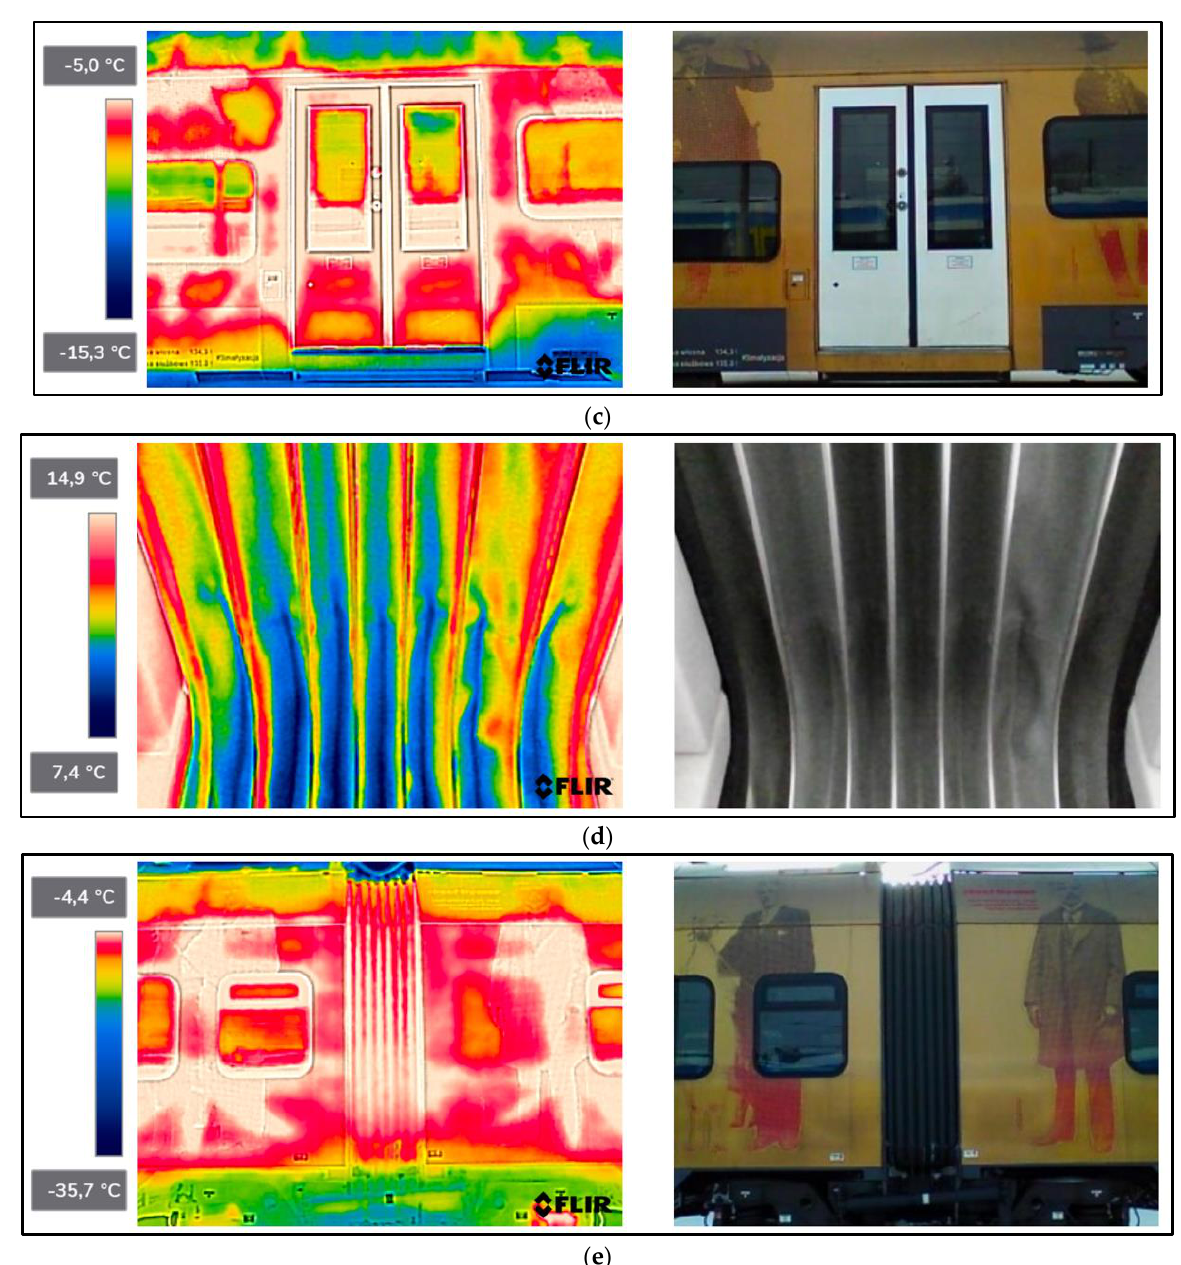
Figure 8. EN76-009 − thermogram of critical components of the railway vehicle: ( a ) door − upper part from inside the vehicle; ( b ) door − lower part from inside the vehicle; ( c ) door from outside the vehicle; ( d ) interconnection from inside the vehicle; ( e ) interconnection from outside the vehicle. Table 4. Average component temperatures of the different types of railway vehicles.